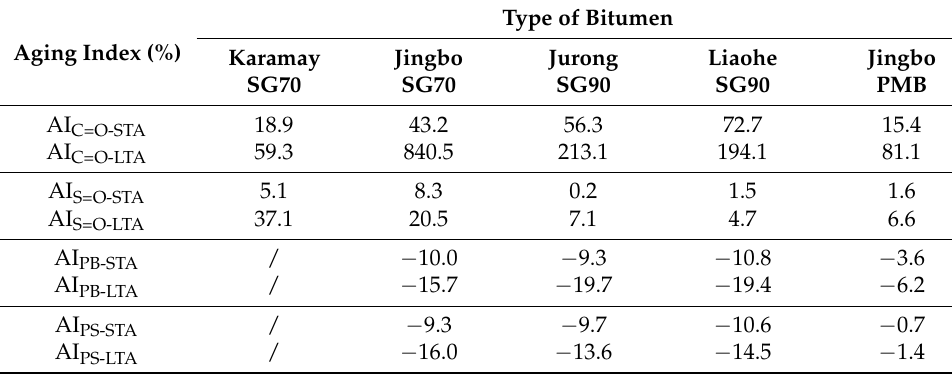
Table 2. Aging indexes based on FTIR analysis of five bitumen